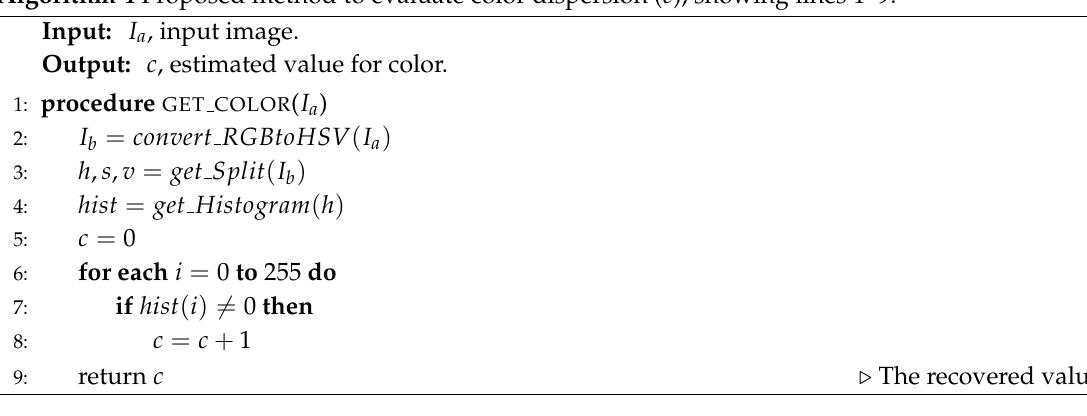
Algorithm 4 Proposed method to evaluate color dispersion ( c ), showing lines